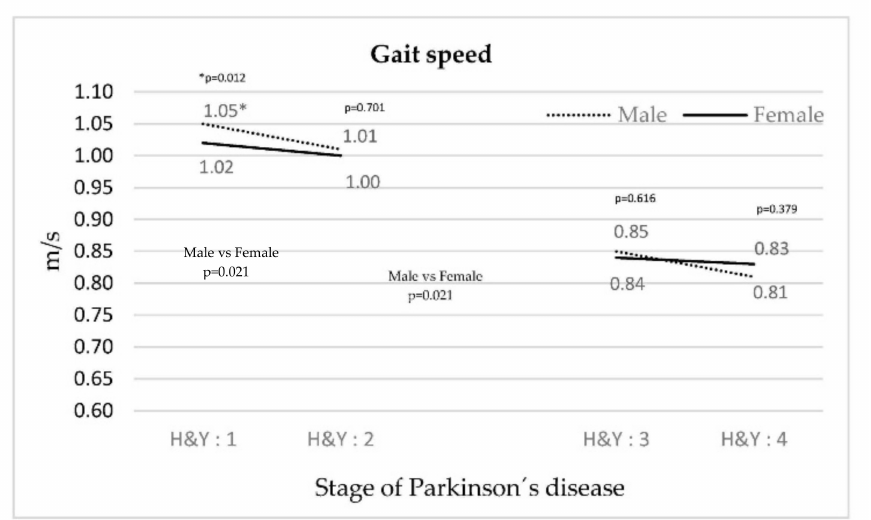
Figure 1. Evolution of gait speed depending on the stage of PD. In Figure 2, the cadence for both genders increases as the PD stage rises. The smallest increase was in women.